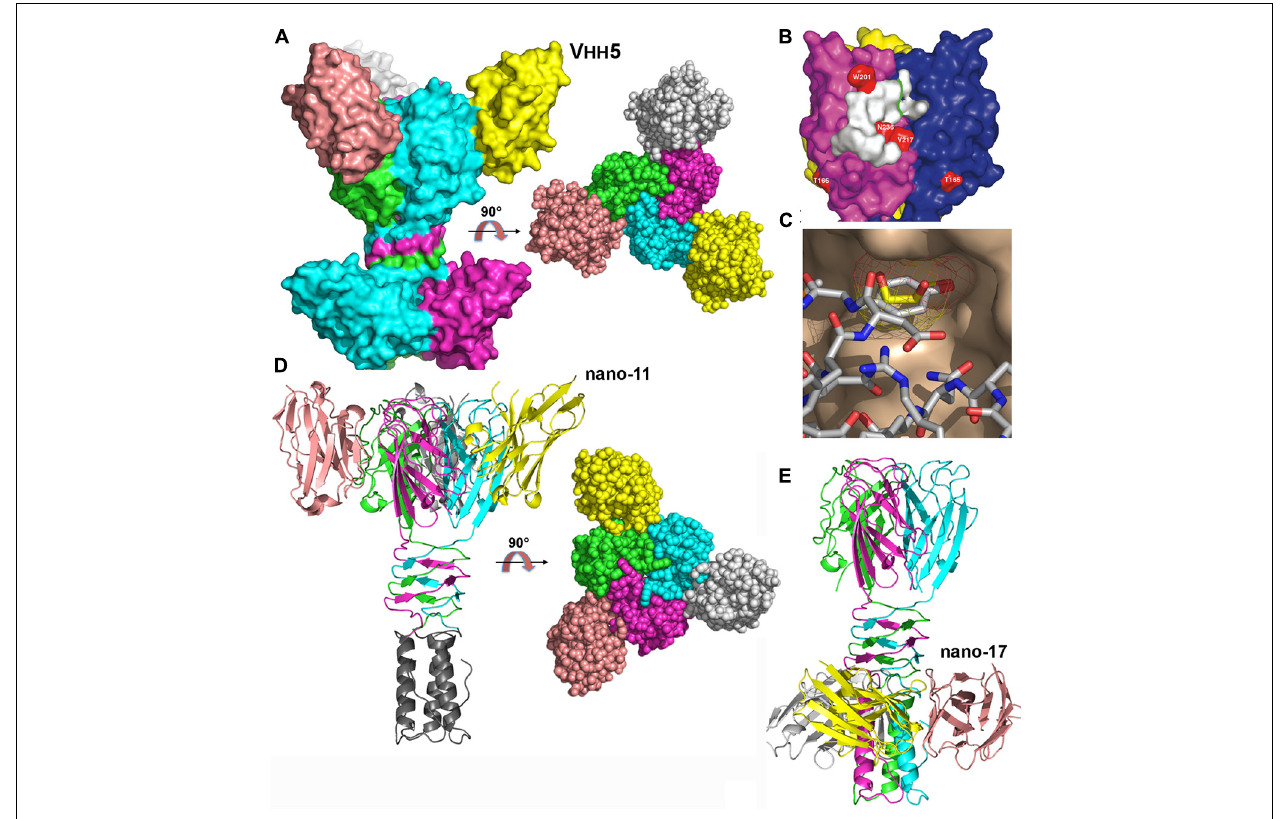
FIGURE 4 | Structures of the receptor binding proteins (RBPs) of phages p2 and TP901-1 in complex with VHHs/nanobodies. (A) Surface representation of the p2 RBP trimer in complex with the neutralizing VHH5 (nano5), and 90 ◦ rotated view. (B) Surface footprint of VHH5 on the RBP trimer surface (white). Mutated residues leading to neutralization escape are indicated in red. (C) View of the superposition of the VHH5 Tyr 55 with glycerol. The RBP surface is colored beige, the